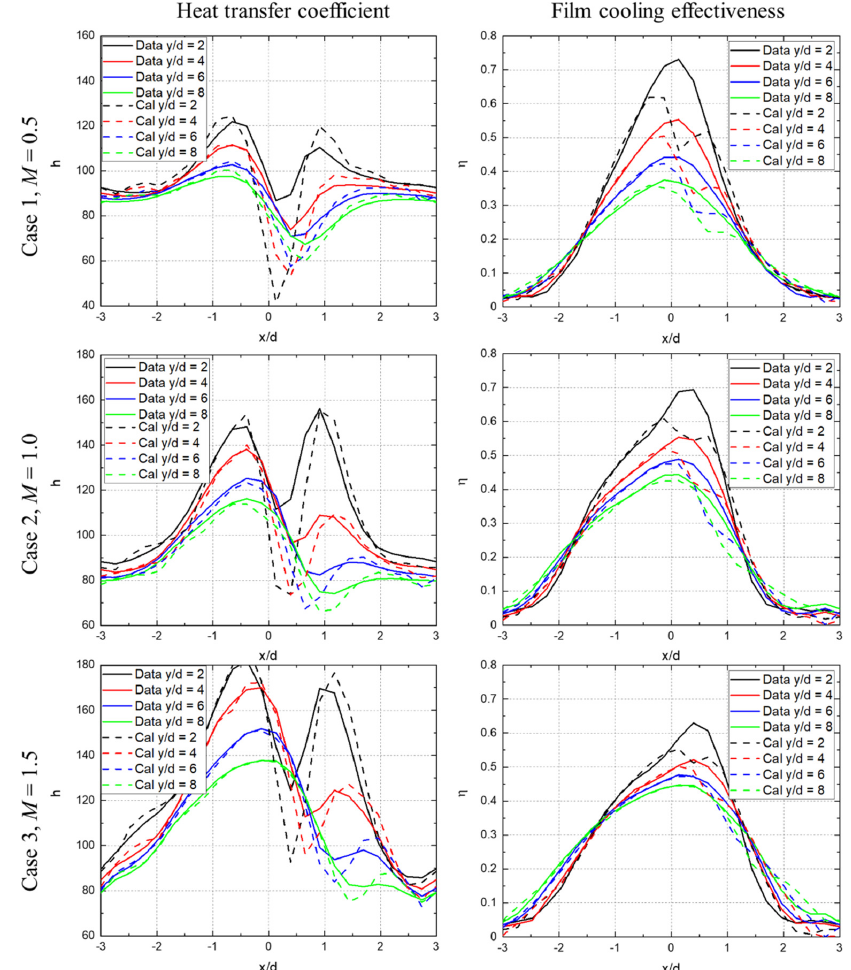
Figure 7. Comparison of heat transfer coefficient and film cooling effectiveness between the data and calculation at different M and y/d .